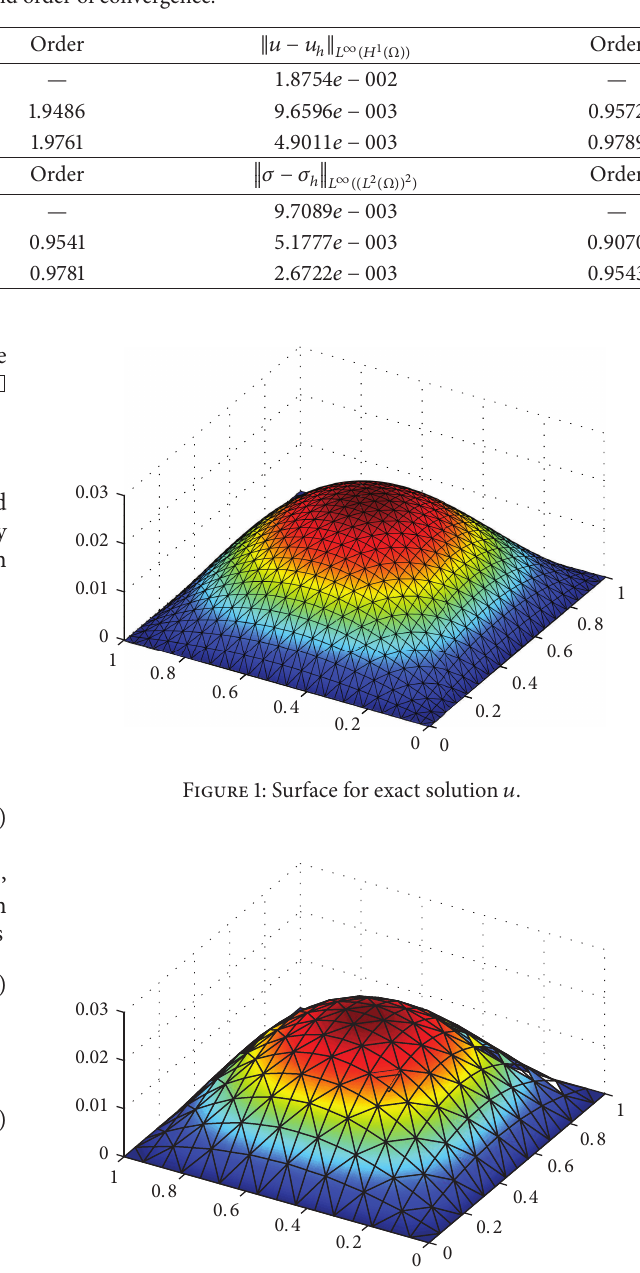
Table 1: Errors and order of convergence.